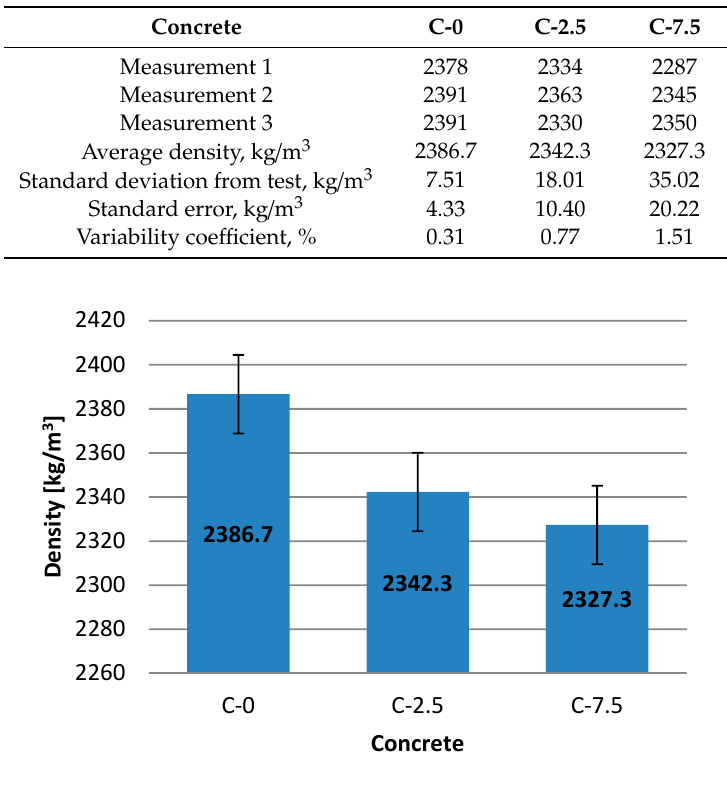
Figure 4. Results of bulk density testing.